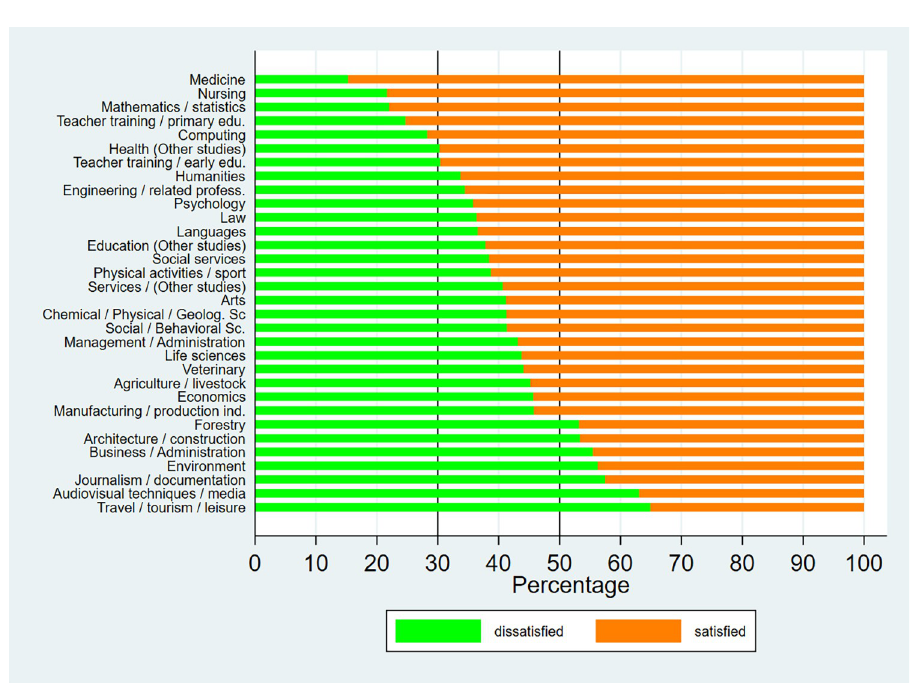
Fig 2. Satisfaction with university education by fields of study (Bachelor—2019). Source: University Graduate Job Placement Survey 2019 (INE). Own calculations.